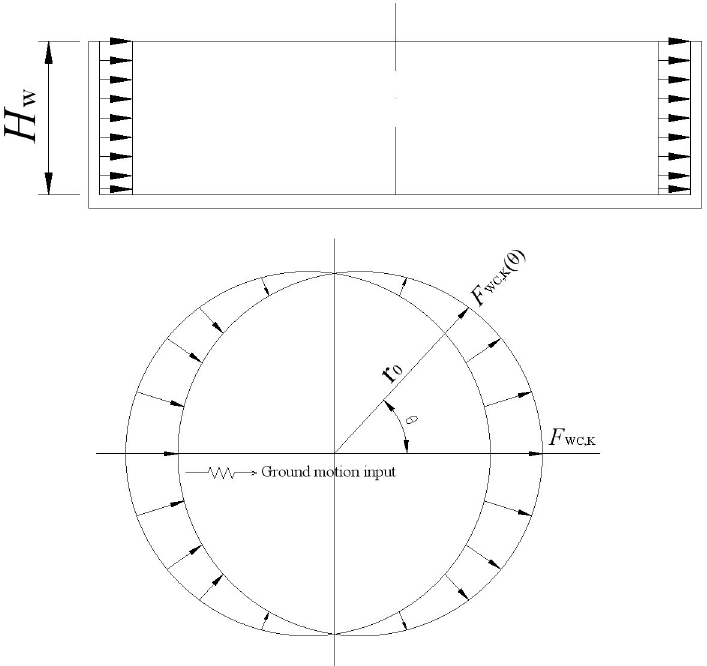
Fig 3. Hydrodynamic pressure distribution of a circular tank in GB 50032–2003 code. a) Along the height of the tank wall. b) Along the circumferential direction of the tank bottom.